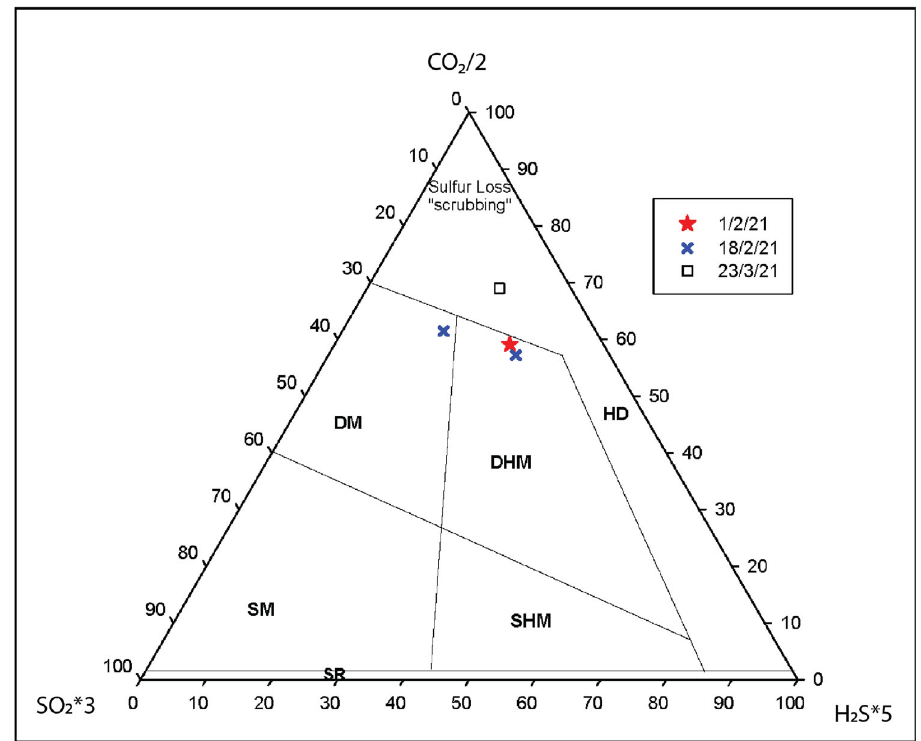
Fig. 6 Plume composition during the extrusive phase from MultiGAS measurements. Ternary diagram of SO 2 *3-CO 2 /2-H 2 S*5 showing the plume compositions obtained during the extrusive phase. HD hydrothermal dominated, DHM deep hydrothermal magmatic, SHM shallow hydrothermal magmatic, DM deep magmatic, SM shallow magmatic. Boundaries were obtained from the Central American Volcanic arc.